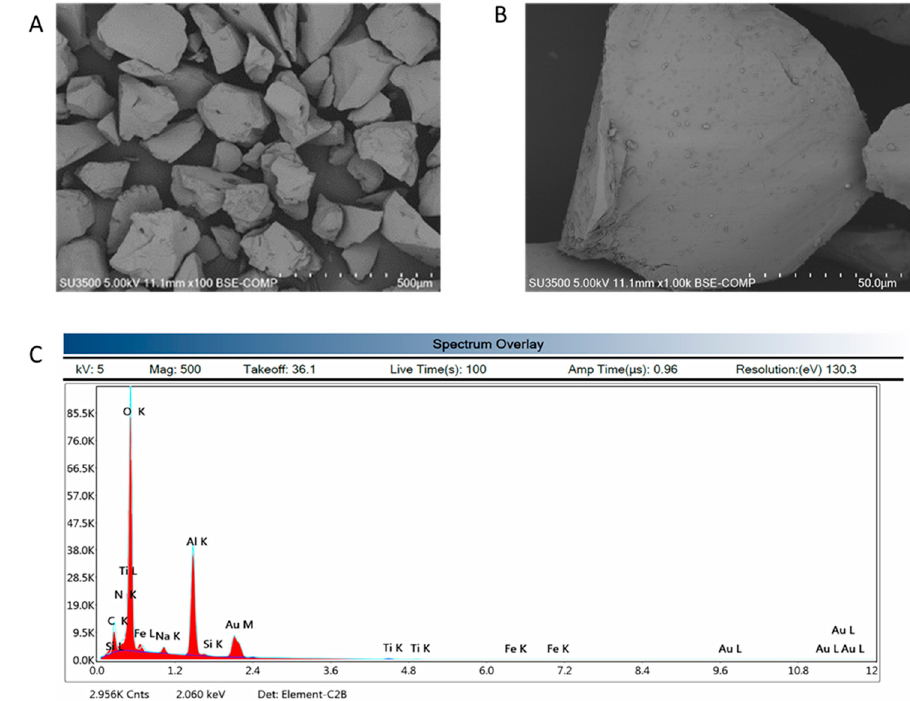
Figure 5. Microstructure of waste corundum via SEM ( A ) at 500X, ( B ) at 1000X, and ( C ) chemical analyses via EDS.